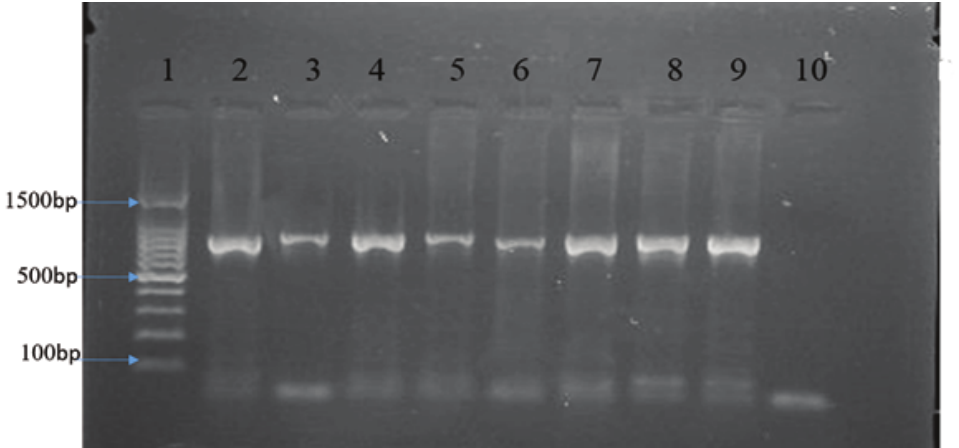
Figure 3: PCR amplification of SHV genes separated. Lane 1 DNA marker: MW 100–1500 bp, lane 2 positive control, lanes 3–9 were positive for SHV genes (797 bp), lane 10 is negative